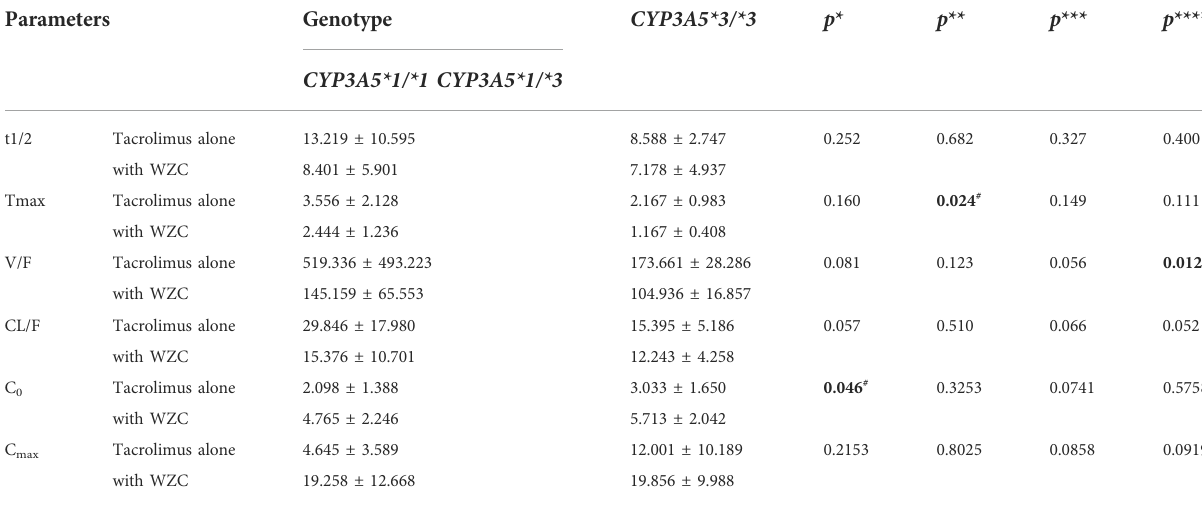
TABLE 4 Pharmacokinetic parameters of tacrolimus with or without WZC in recipients with. different CYP3A5 genotype ( n = 15).